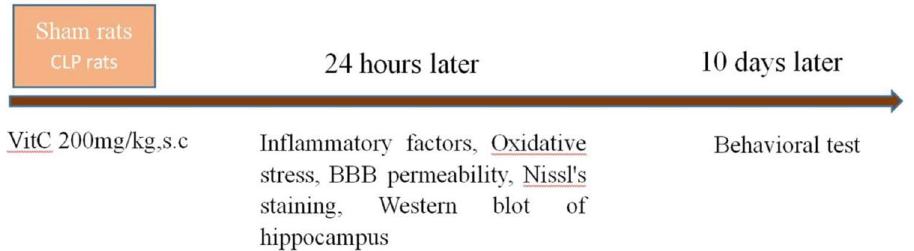
Figure 6. Experimental design. Twenty-four hours after CLP-induced sepsis model was established, inflammatory factors, oxidative stress of serum and hippocampus, BBB permeability, Nissl’s staining of hippocampus, and Western blot of hippocampus were evaluated. Ten days after CLP-induced sepsis model, behavioral tests of rats were